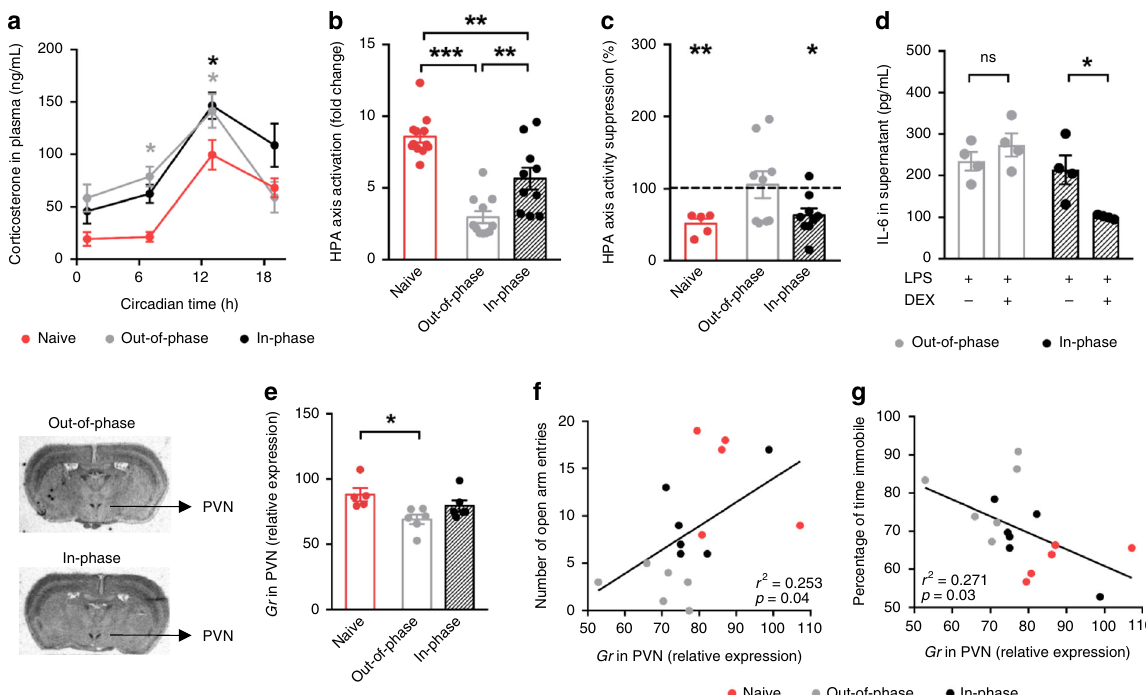
Fig. 2 The time of maternal exposure to GCs predicts the offspring ’ s HPA axis function. Scheme of the gestational intervention is shown in Fig. 1a. Long- term effects on the offspring ’ s circadian stress system were assessed at systemic ( a – d ) and molecular ( e – g ) levels. To con fi rm the effect of the preterm manipulation itself (handling and corticosterone (CORT) administration from gestational day (GD) 11.5 until birth) on hypothalamic-pituitary-adrenal (HPA) axis function, we included a naive group of adult mice (in red) whose mothers were left undisturbed during their whole pregnancy. a Circadian pro fi le of CORT in plasma in constant darkness, (naive ZT1 n = 7, ZT7 n = 7, ZT13 n = 10 and ZT19 n = 8; out-of-phase ZT1 n = 9, ZT7 n = 7, ZT13 n = 11 and ZT19 n = 8; in-phase ZT1 n = 11, ZT7 n = 10, ZT13 n = 11, and ZT19 n = 7). Gray or black asterisks indicate differences between the naive group and out-of-phase or in-phase, respectively. b HPA axis activation as fold change of CORT in plasma before and after FST (naive n = 12, out-of-phase n = 11, in- phase n = 10). c Dexamethasone (DEX) suppression of CORT production expressed as percentage of vehicle treatment (dotted line) (naive n = 5, out-of- phase n = 9, in-phase n = 9). CORT was measured in duplicates. d Glucocorticoid receptor (GR) sensitivity assessed by lipopolysaccharide (LPS)-induced interleukin − 6 (IL − 6) production in whole blood with/without DEX ( n = 4/treatment/group). IL-6 measurements were run in duplicates. e Gr relative mRNA expression in the hypothalamic paraventricular nuclei (PVN) by in situ hybridization (three sections were quanti fi ed and averaged/mice, naive n = 5, out-of-phase n = 6, in-phase n = 6), on the left, representative images show the quanti fi ed region. f , g Linear correlation between, Gr expression in PVN and number of open arm entries ( f ) and the percentage of time immobile ( g ). Data in b , e were analyzed by one-way b F (2,30) = 28.84, p < 0.0001; e F (2,14) = 4.85, p = 0.0251) and data in a by two-way ANOVA (treatment effect F (2,93) = 9.28, p = 0.0002) followed by Sidak ’ s multi-comparison test. Data in c were analyzed by two-sided unpaired t -test for each group independently (Naive VEH vs DEX, t = 3.881, df = 9, p = 0.0037; in phase vehicle (VEH) vs DEX, t = 2.26, df = 16, p = 0.0382). Data in d were analyzed by two-sided Mann – Whitney test for each group ( p = 0.0286). * p < 0.05, ** p < 0.01, *** p < 0.001. Source data are provided as a Source Data fi